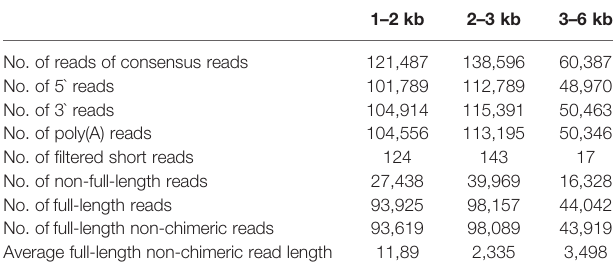
TABLE 1 | Summary of PacBio single-molecule long-read